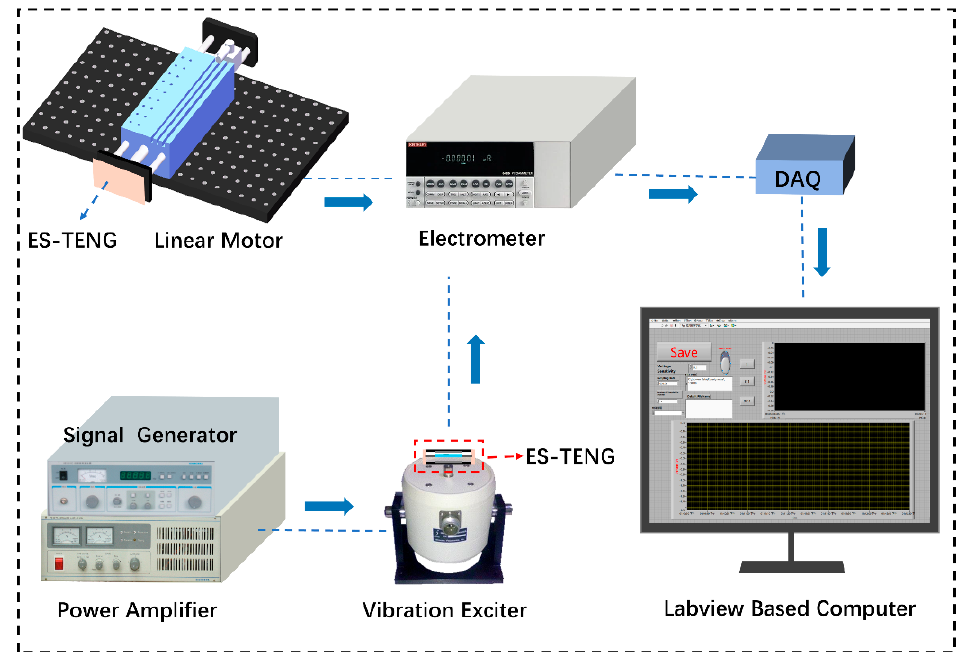
Figure 3. Schematic of the experimental apparatus for assessing ES − TENG sensor performance.